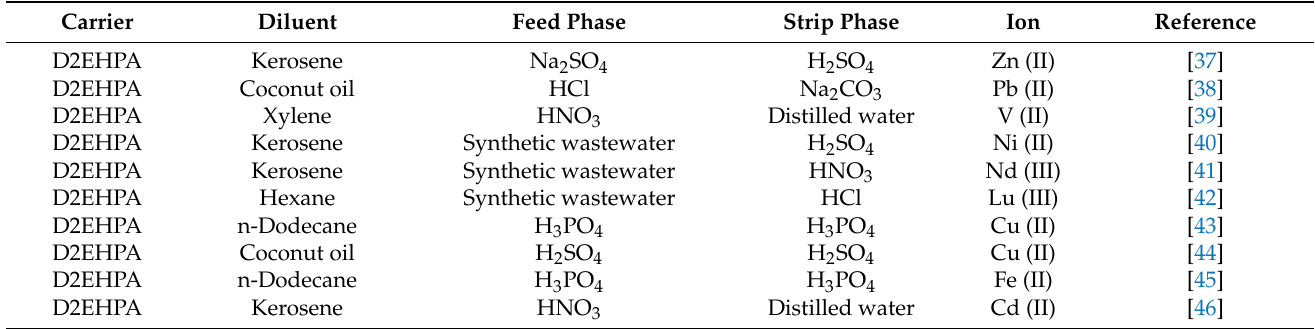
Table 3. Literature review on D2EHPA as the carrier in the supported liquid membrane.